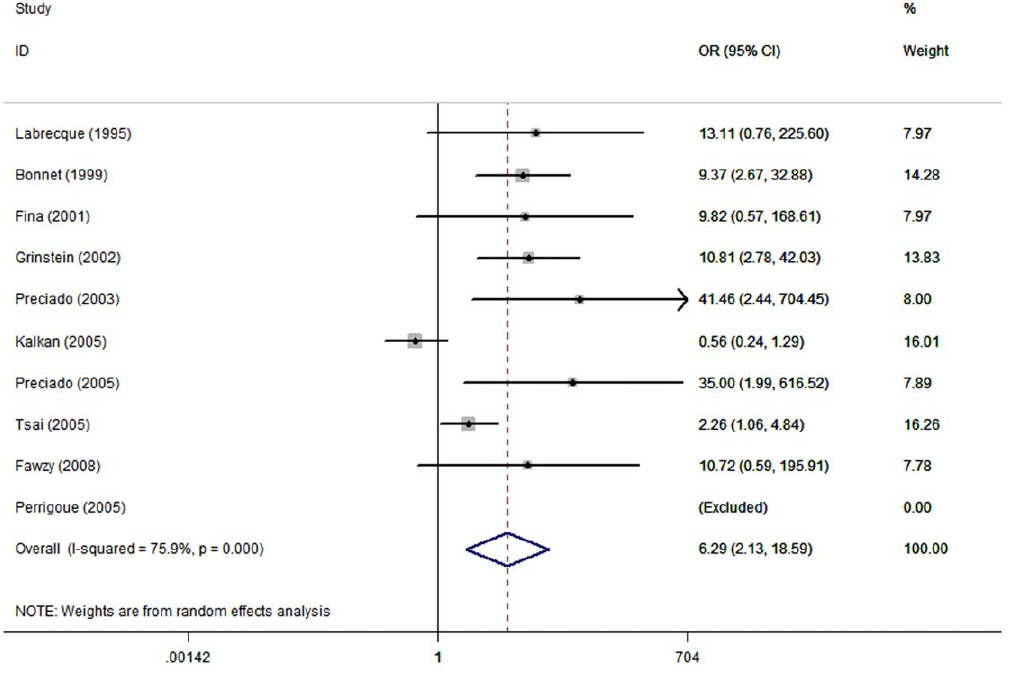
Figure 2. Association between EBV infection and breast carcinoma risk (ORs). Ten studies that adopted non-breast-cancer control groups [2–11] were selected for the analysis of EBV infection and human breast carcinoma risk. One [7] was excluded automatically after data pooling for the absence of EBV DNA in both patient and control groups. Random-effects model was chosen to estimate the ORs after pooling due to the high heterogeneity among these studies ( I 2 =75.9%, P =0.000). A significant, 6.29-fold (95% CI=2.13–18.59) increased breast carcinoma risk in patients with an EBV infection was shown.